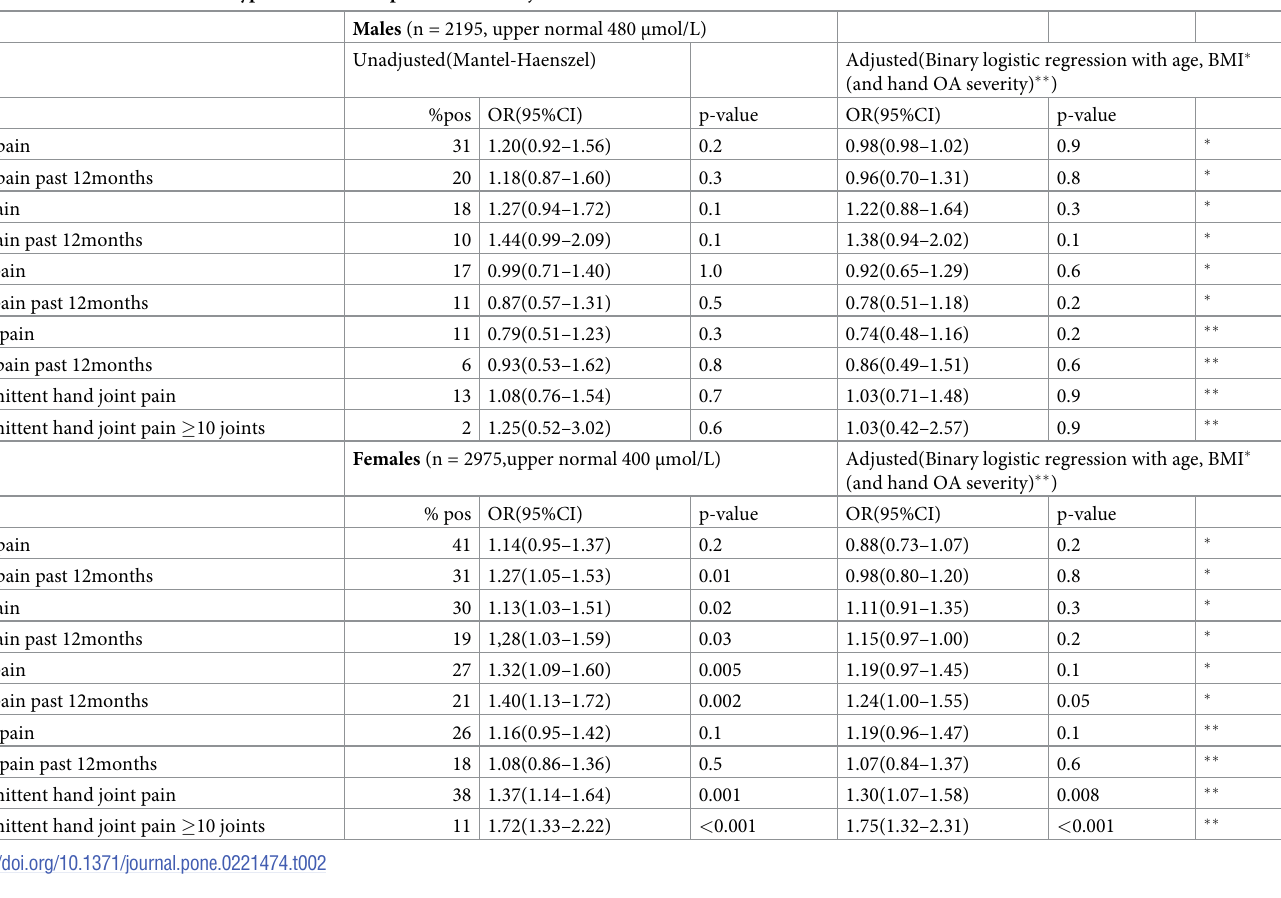
Table 2. The association between hyperuricemia and pain at different joint sites.